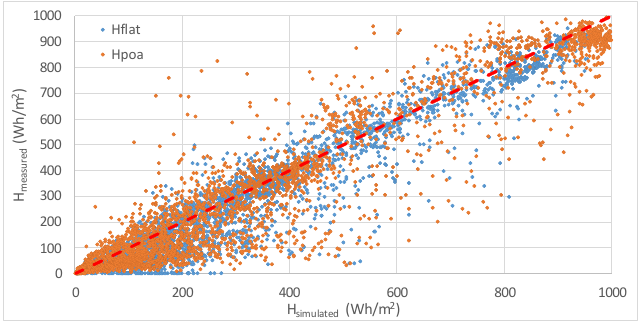
Figure 7. Transposition of the solar irradiation to plane-of-array (red line is to guide your eyes).